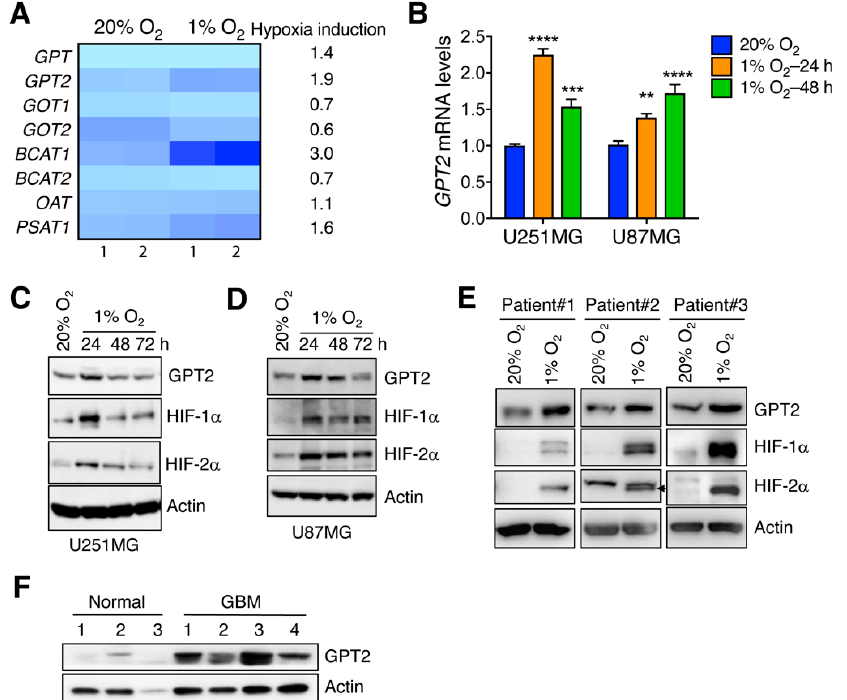
Figure 1. Hypoxia induces GPT2 expression in GBM cells. ( A ) RNA-seq analysis of eight aminotransferases in U251MG cells exposed to 20% or 1% O 2 for 24 h. The color indicates normalized mRNA expression levels. Fold changes in mRNAs by hypoxia are shown on the right. The sample numbers are shown at the bottom. ( B ) qRT-PCR analysis of GPT2 mRNA in U251MG and U87MG cells exposed to 20% or 1% O 2 for 24 or 48 h (mean ± SEM, n = 3–6). ** p < 0.01, *** p < 0.001, **** p < 0.0001 vs. 20% O 2 by one-way ANOVA with Dunnett’s test. ( C ) Immunoblot analysis of indicated proteins in U251MG cells exposed to 20% or 1% O 2 for 24–72 h. ( D ) Immunoblot analysis of indicated proteins in U87MG cells exposed to 20% or 1% O 2 for 24–72 h. ( E ) Immunoblot analysis of indicated proteins in patient-derived GBM spheres exposed to 20% or 1% O 2 for 48 h. ( F ) Immunoblot analysis of indicated proteins in normal human brain and human GBM tissues. The sample numbers are shown on the top.